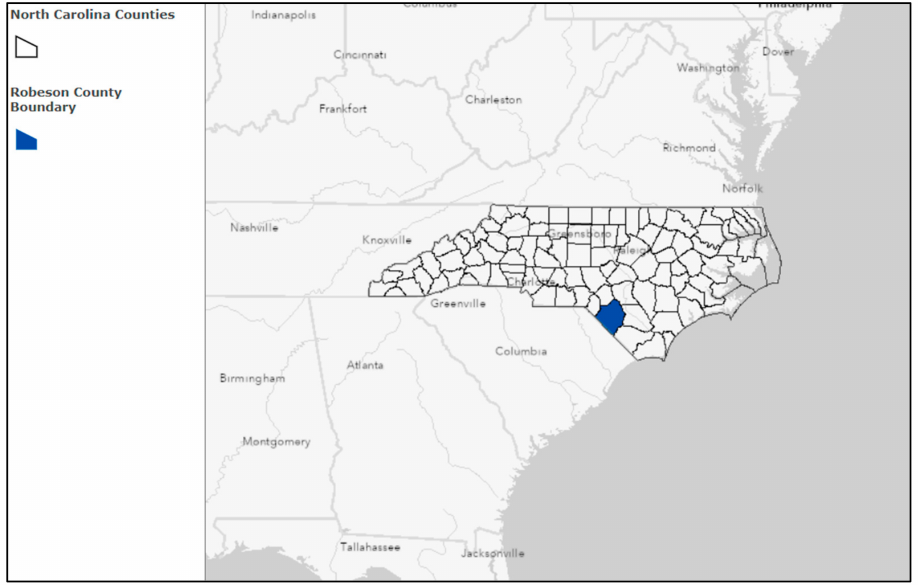
Figure 2. Robeson County, North Carolina